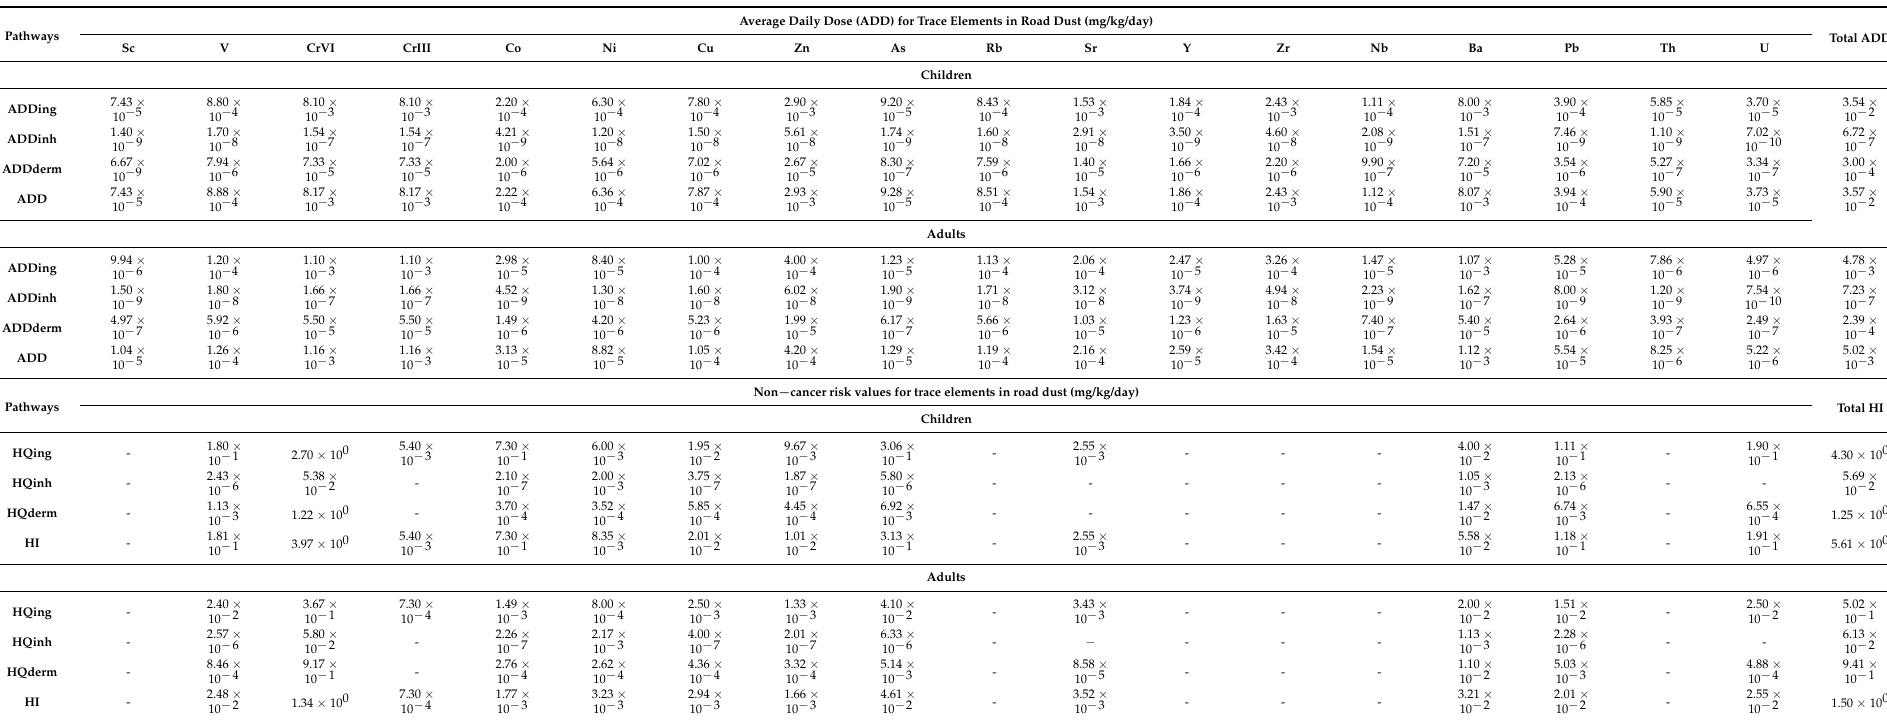
Table 12. Average daily dose (ADD), HQ, and HI values for trace elements in road dust via ingestion, inhalation, and dermal exposure pathways for children and